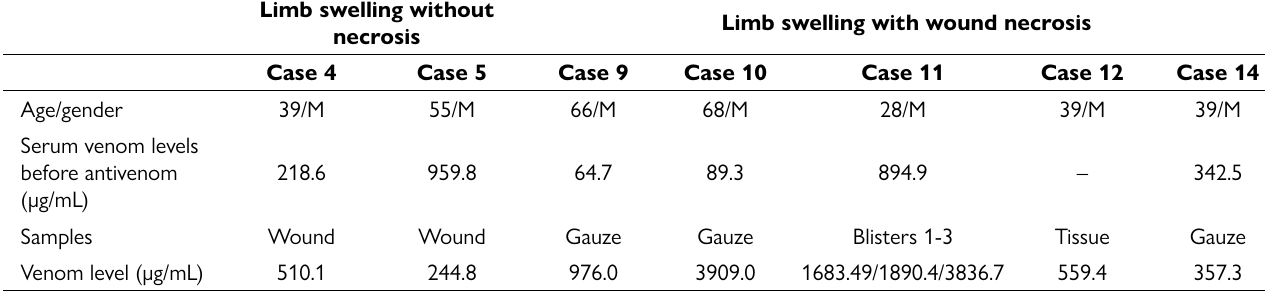
Table 5. The concentration of whole venom in serum, excised tissue, and wound discharge